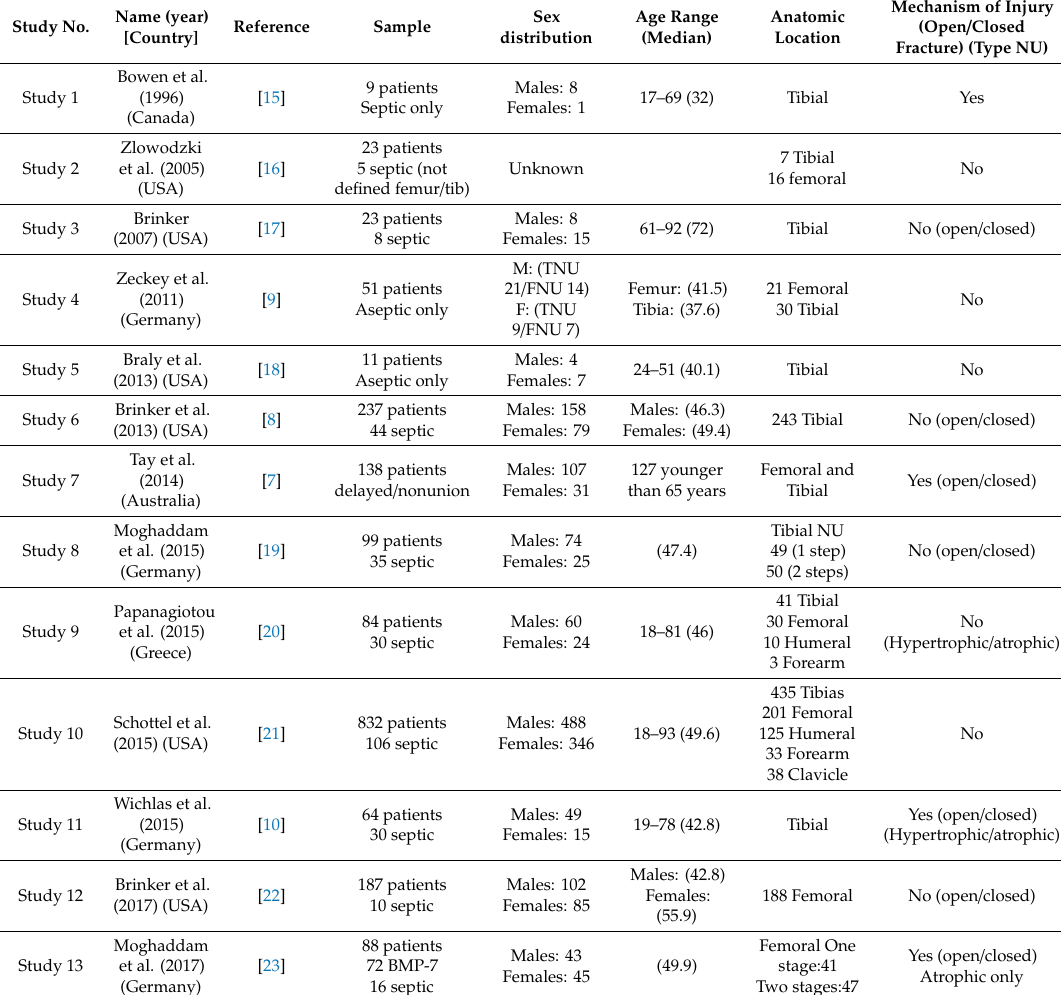
Table 1. Demographic data and baseline characteristics of the primary